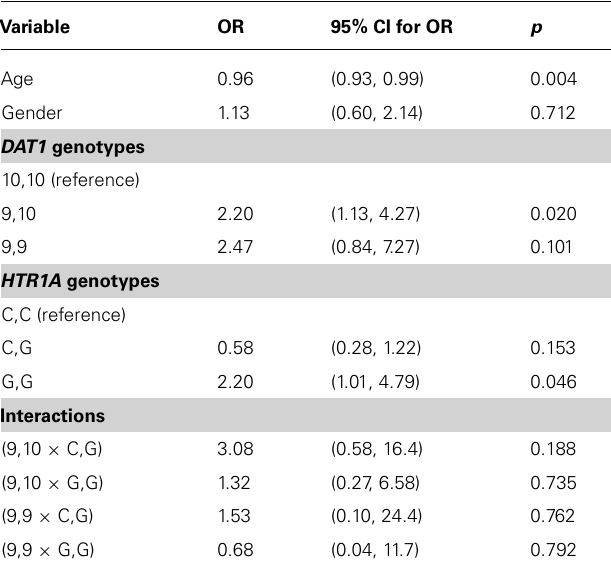
Table 2 | Results from an uncontrolled logistic regression models (all considered parameters) predicting BPD.